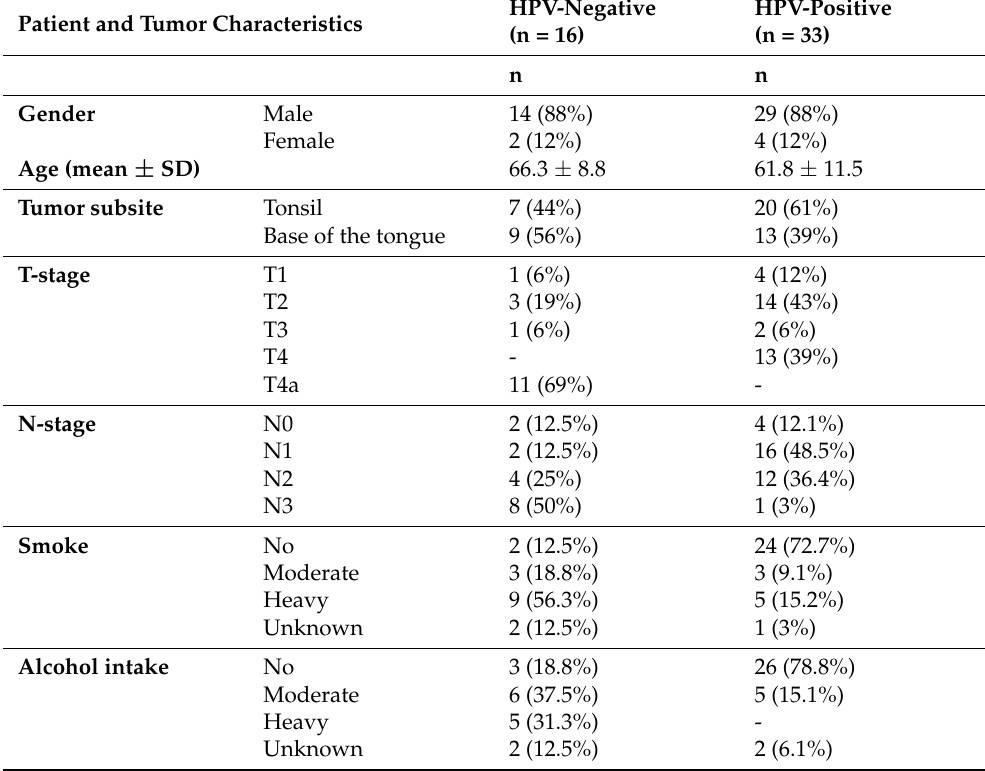
Table 2. Characteristics of patients and tumors in the validation set. Patient and Tumor